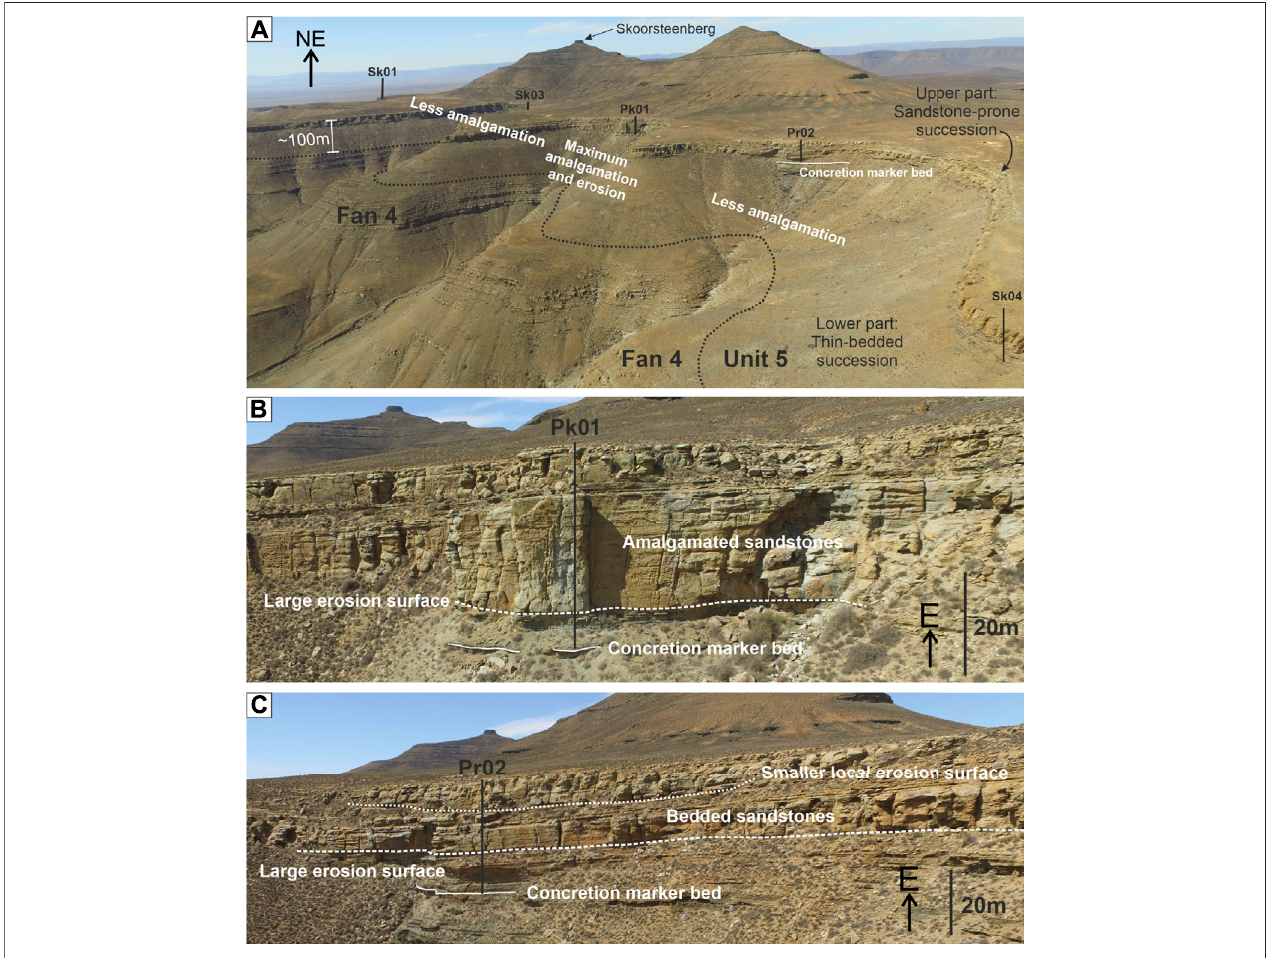
FIGURE 9 | (A) Uncrewed Aerial Vehicle imagery photograph of the western side of the outcrop indicating areas of maximum amalgamation and erosion in the upper sandstone-prone part of the stratigraphy. The part of the correlation panel shown in the photo is highlighted in Figure 6 . (B) Photo of the amalgamated fi ll of the erosion surface at log PK01 (shown in Figure 6 ), with location indicated in (A) . (C) Photo of the bedded fi ll of the erosion surface at log PR02 (shown in Figure 6 ), with location indicated in (A) . An erosion surface present higher up the stratigraphy is also highlighted.